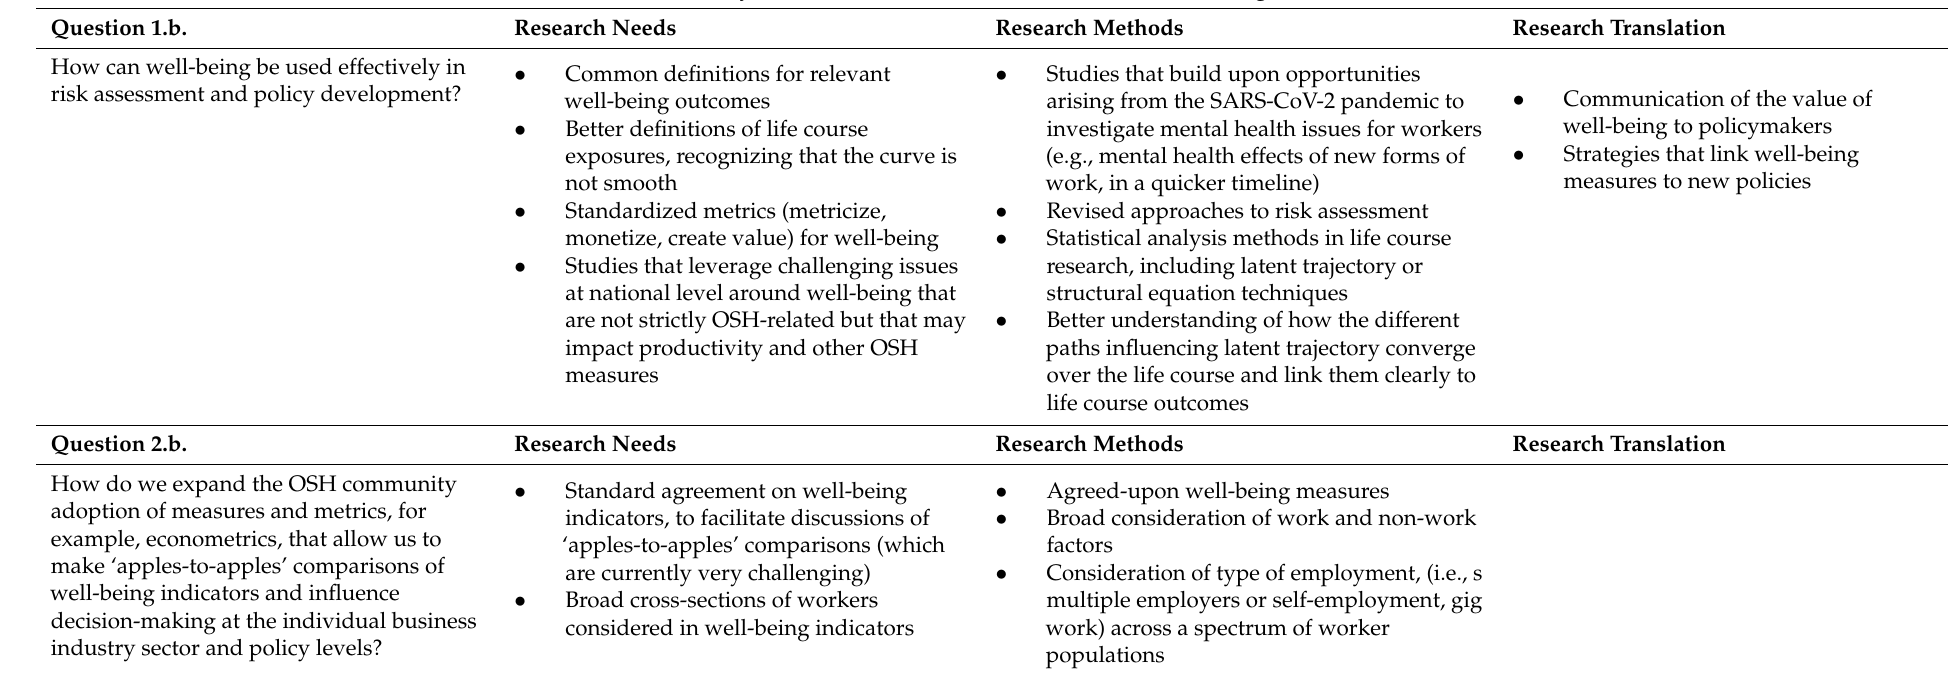
b. Summary of Needs, Methods, and Translation in Well-being